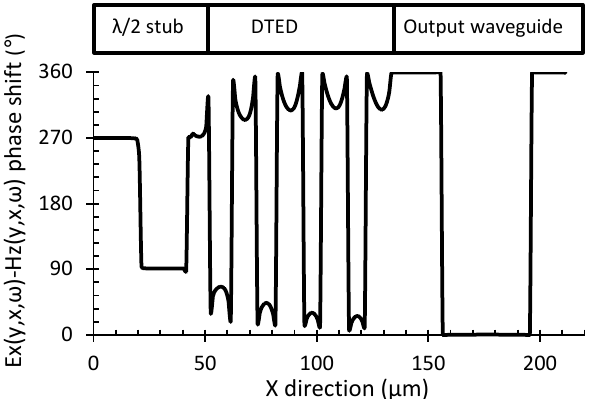
Figure 11: Space evolution of the y direction EM power P EHy at the fundamental frequency ω in a slice at x=130